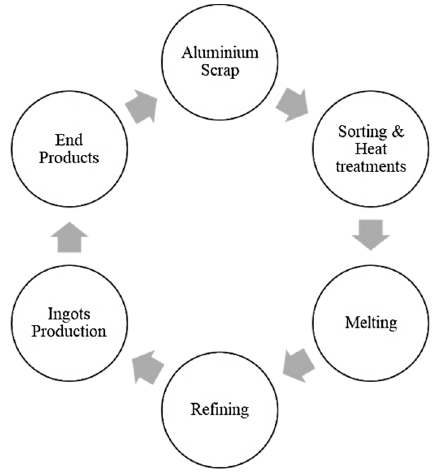
Figure 2. The processes in the recycling of Al scrap.